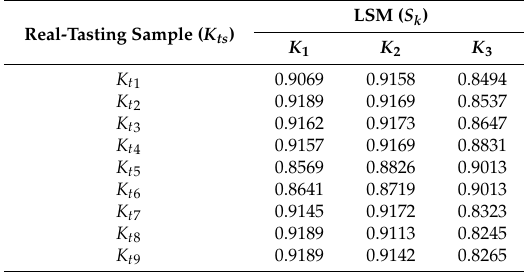
Table 3. LSM values between K ts ( s = 1, 2, . . . , 9) and K k ( k = 1, 2, 3) for the engine